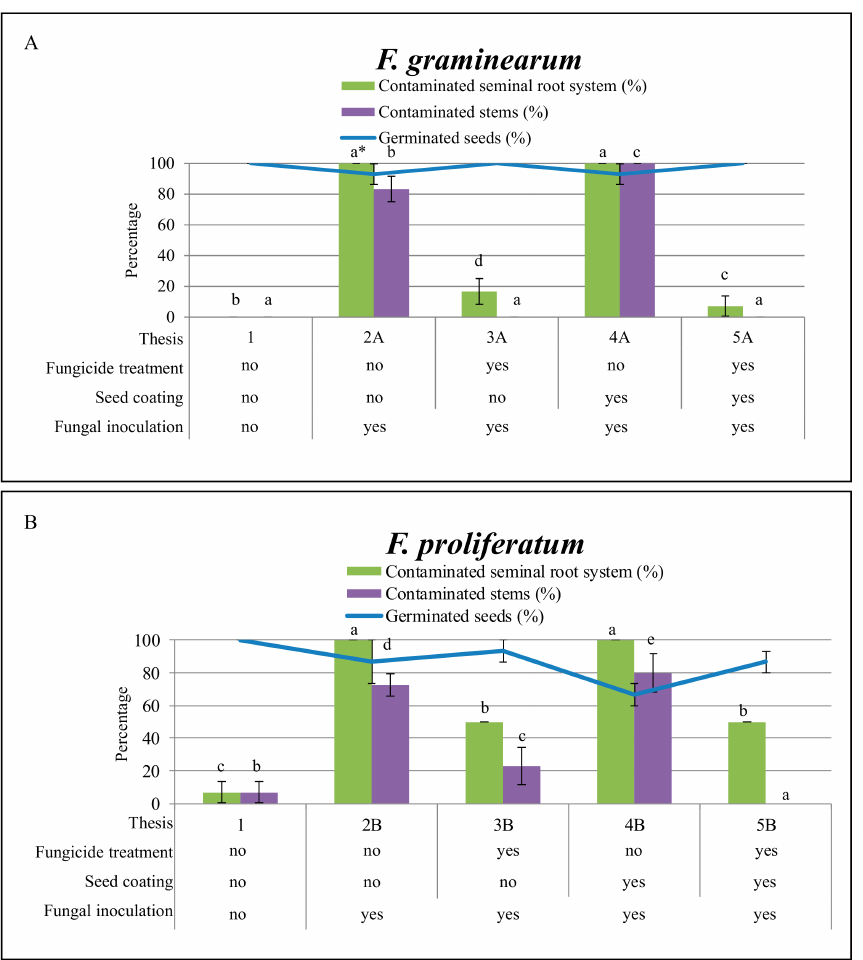
Figure 2. Percentage of seed germination and fungal contamination in maize seedlings grown in Petri dishes containing synthetic medium, after different and combined treatments (fungicide application, plasma coating, fungal inoculation). Two separated experiments were carried out for F. graminearum ( A ) and F. proliferatum ( B ). * Values with different letters are statistically different with p < 0.05 as determined by one-way analysis of variance (ANOVA) followed by the Tukey